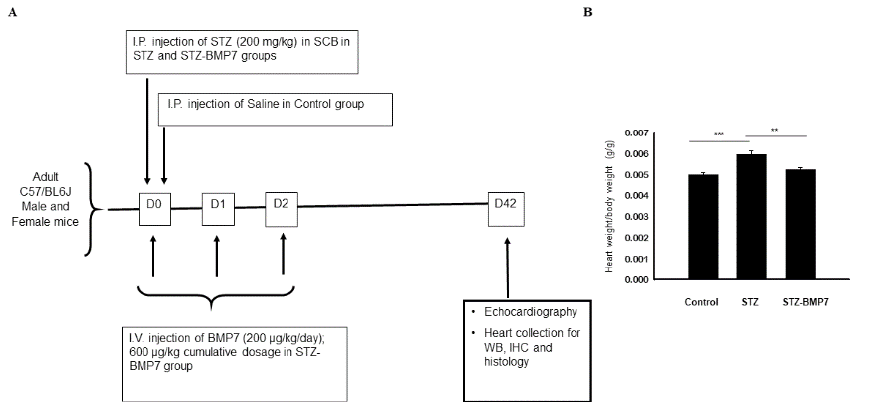
Figure 1. Design of experimental study and BMP-7 reduces heart weight in diabetic heart. ( A ) A schematic image showing the study design, doses, and injection schedule. ( B ) The graph shows the ratio of heart weight-to-body weight (g/g) of all mice after 6 weeks of STZ injection. Statistical analysis was performed using One-Way ANOVA, which was followed by Tukey test; Error bars = mean ± S.E.M. ** p < 0.01, *** p < 0.001; n = 16/group. BMP7: bone morphogenetic protein-7; D: day, IHC: immunohistochemistry; SCB: sodium citrate buffer; STZ: streptozotocin; WB: Western blotting.